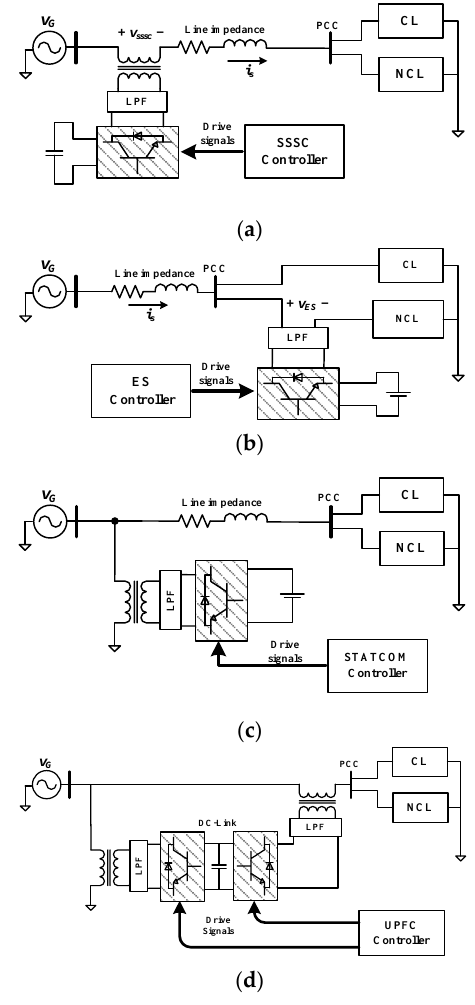
Figure 10. Typical configuration of ES and FACTS devices applied in power systems. ( a ) SSSC; ( b ) ES-2; ( c ) STATCOM; ( d ) UPFC.